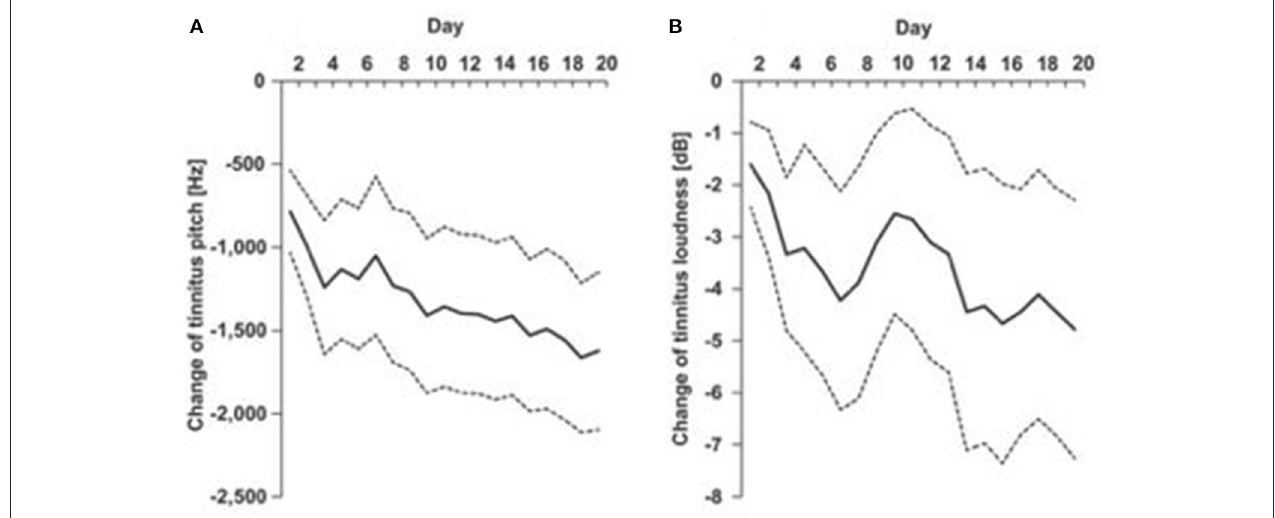
FIGURE 1 | EMA of tinnitus pitch (A) and loudness (B) recorded each day of a 20 day multisensory training program [Spiegel et al. (89), used with permission of authors].